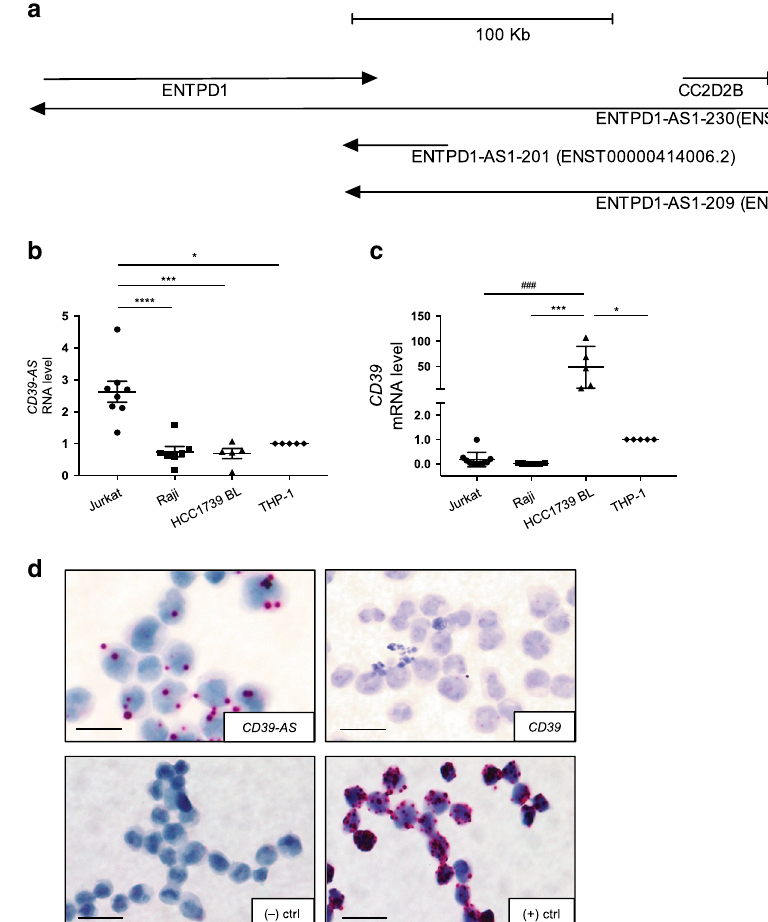
Fig. 1 CD39-AS RNA is located at the 3 ′ end of the human CD39 gene and regulates CD39 mRNA levels. a Graphical representation of the 10q24.1 human locus, including CD39/ENTPD1 , CC2D2B , and CCNJ genes, ENTPD1-AS1-230 ( ENSG00000226688.7 ) long transcript antisense RNA variant, and two ENTPD1/CD39-AS splice variants. The two ENTPD1-AS1-209 ( ENST00000452728.5) and ENTPD1-AS1-201 ( ENST00000414006.2) splice variants, predicted by Ensembl and UCSC genome browsers, were experimentally con fi rmed by qRT-PCR analysis. These were both transcribed from the 3 ′ end of the human ENTPD1/CD39 gene. b , c Mean ± SEM CD39-AS RNA and CD39 mRNA levels in Jurkat ( n = 8 replicates), Raji ( n = 7 replicates), HCC1739BL ( n = 5 replicates), and THP-1 ( n = 5 replicates) cell lines. Because of high CD39-AS RNA and concomitantly low CD39 mRNA levels, Jurkat cells were used for all subsequent experiments as positive control for antisense RNA expression. BaseScope and RNAScope chromogenic assays were used to detect CD39-AS RNA and CD39 mRNA transcripts in cytospins of Jurkat cells. d Representative images of Jurkat cells stained with CD39-AS BaseScope, CD39 RNAScope, and negative and positive control staining is shown (magni fi cation ×40, scale bar: 25 μ M). A representative of three independent experiments is shown. Comparisons in b , c were made using one-way ANOVA, followed by Tukey ’ s multiple comparisons test ( b : * P = 0.013; *** P = 0.0002; **** P ≤ 0.0001; c : * P = 0.013; *** P = 0.0004; ### P =